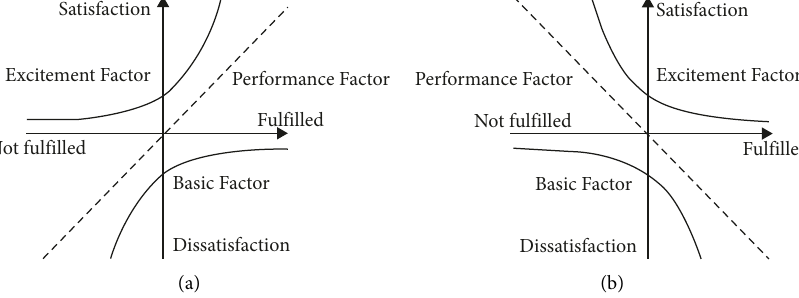
Figure 4: Three-factor theory of customer satisfaction. (a) Positive correlations. (b) Negative